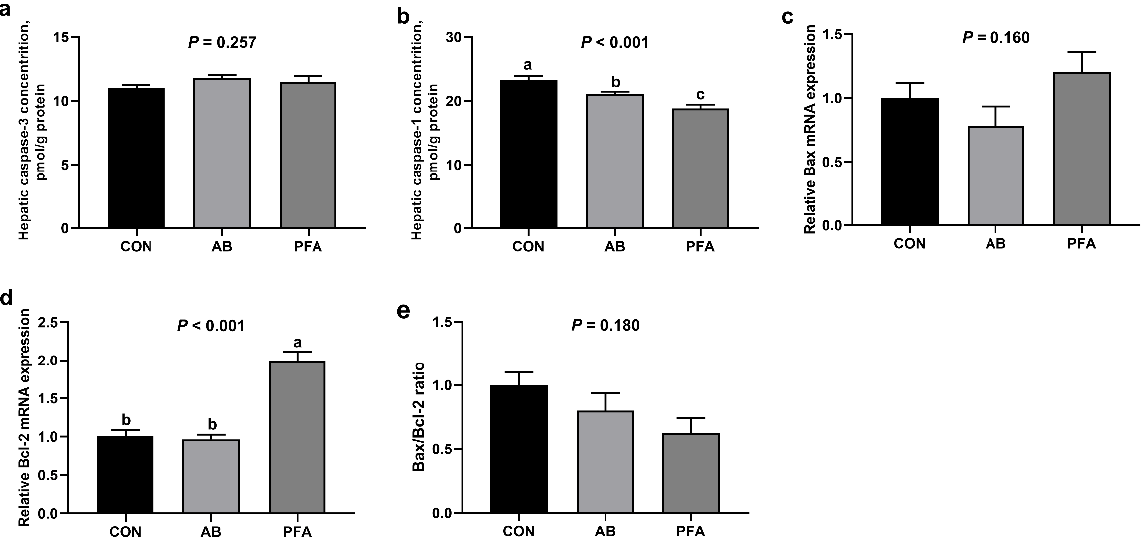
Figure 3. Effects of paraformic acid (PFA) supplementation on hepatic apoptosis indicators in broiler chickens. ( a ) Caspase-3; ( b ) Caspase-1; ( c ) Bax ; ( d ) Bcl-2 ; ( e ) Bax/Bcl-2 ratio. CON, broiler chickens receiving basal diet; AB, broiler chickens receiving basal diet supplemented with 50 mg/kg are mean ± standard error ( n = 7). a,b,c Means with different superscripts differ ( p < 0.05).